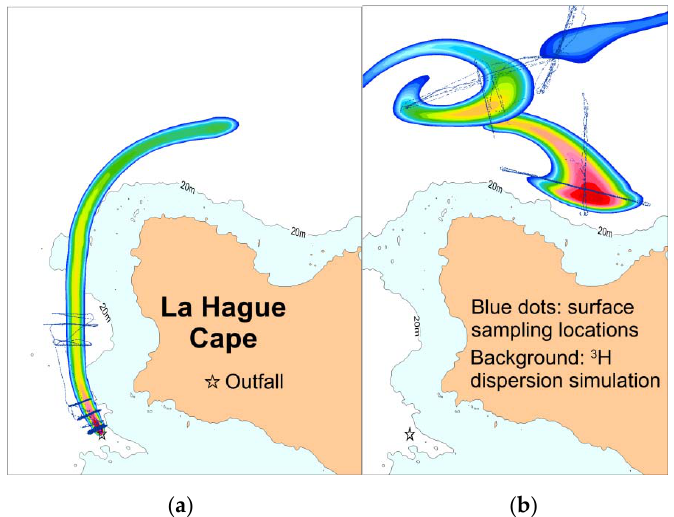
Figure 5. Sampling locations during the DISVER 2011 campaign (13,400 in ‐ depth samples between 5 and 11 April 2011) ( a ) 0–2 hours after a release ( b ) 3–8 hours after a release.